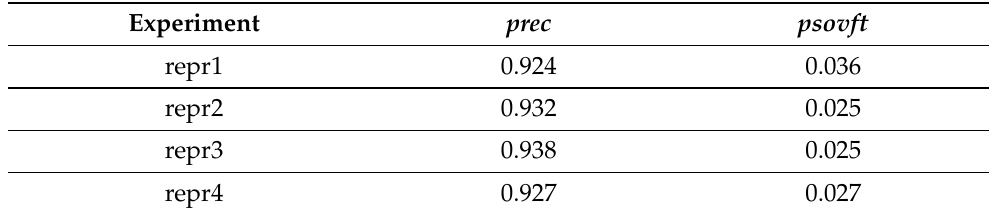
Table 6. Results of 4 different sessions with the same hyperparameter settings: f = 0.2, final _ prec = 0.75, des _ feat _ num =